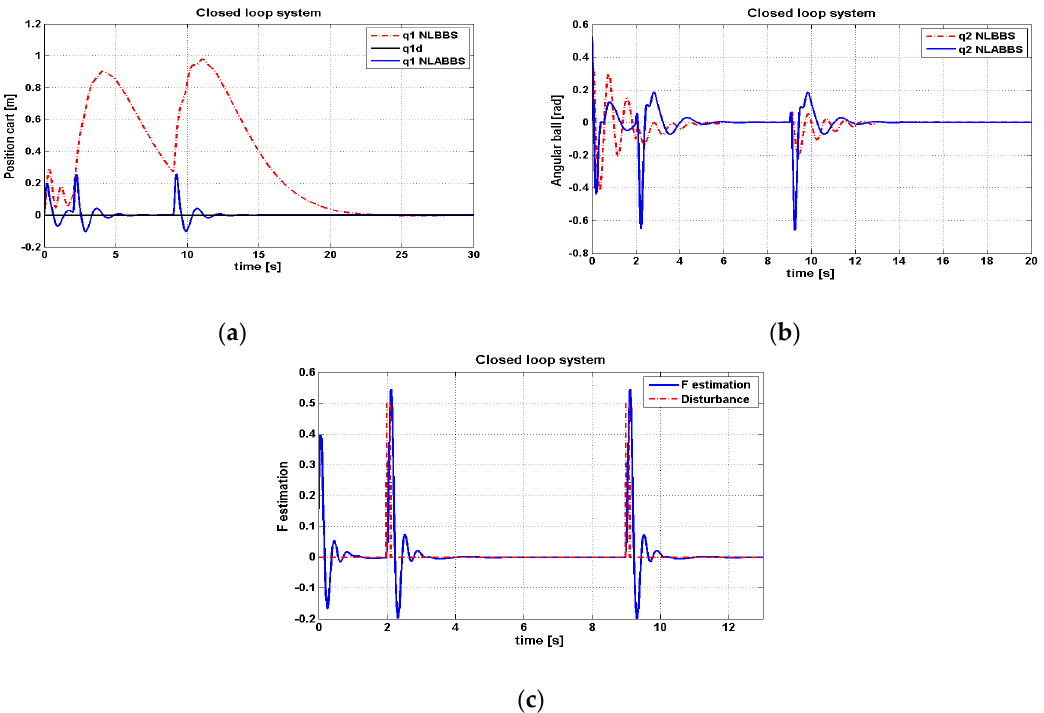
Figure 8. Dynamic Responses of the ( a ) cart displacement, ( b ) ball angular position, and ( c ) disturbance estimation with the two controllers under disturbance.